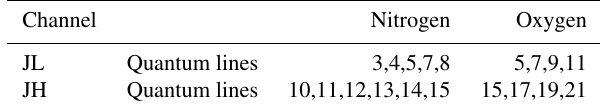
Table 1. The respective quantum lines from both nitrogen and oxy- gen in a PRR spectrum detected by the RALMO temperature poly- chromator. Note the given quantum lines are valid for both the Stokes and anti-Stokes